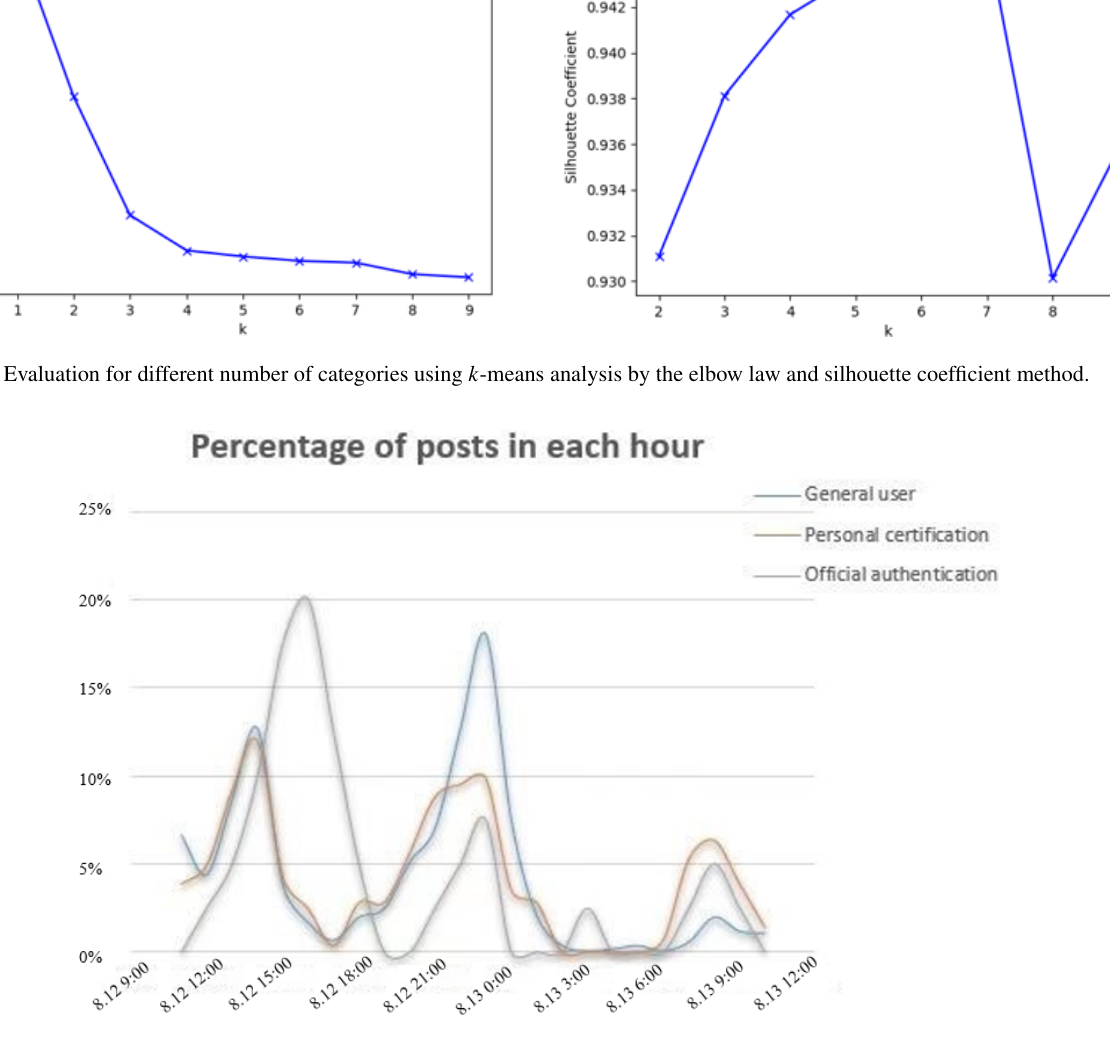
Figure 3. Ratio of hourly microblog posts to the total for three types of publisher. Time is given in the format month.day hour:minute (local